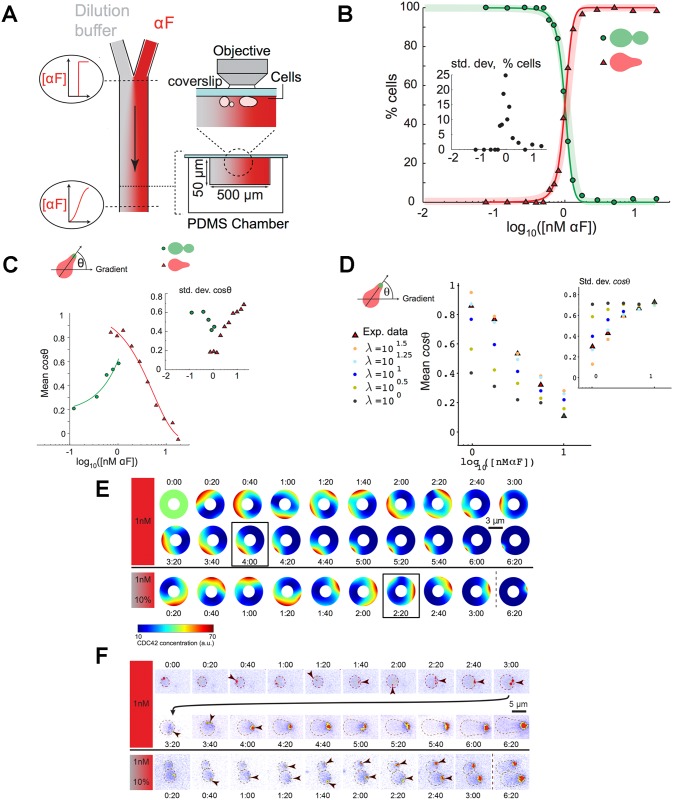
Response to pheromone gradients and model prediction.A) Producing pheromone gradients in a laminar flow chamber. Pheromone mixed with a fluorescent dextran and a dilution buffer enters through two ports and diffusion between the two fluid streams creates a temporally stable, gradient (see Experimental Procedures in S1 Text, and Fig C in S1 Text for more details). The left hand view is from the top of the apparatus and right hand views are two different magnifications of a cross-section, showing the cells attached to the coverslip that forms the roof of the chamber. B) The transition between budding and shmooing, quantified as in Fig 2B. The lightly shaded, thick curves show the data from spatially uniform pheromone concentrations (Fig 2B) for comparison. For every cell, the difference in concentration between the two edges of the cell was > 5% (expressed relative to the mean concentration that the cell experienced). The inset shows the standard deviation. C) The accuracy of gradient detection as a function of pheromone concentration. Accuracy is defined as the mean cosine of the angle between the gradient and the line that connects the Spa2 polar cap to the center of the cell. D) The accuracy of gradient detection as a function of pheromone concentration for solutions to our model. For different damping coefficients λ, the gradient detection and the standard deviation were computed. We observe that the value of λ which fits the data the best is 101.25 which means 1/λopt ≈ 3 mn. E) We show the timing of polarization in representative numerical simulations of cells exposed to a uniform field and gradient field of α-factor (images are shown every 20 minutes). F) Comparing the timing of polarization in individual cells exposed to a uniform field (top) and a gradient (bottom) of α-factor. Images were taken every 20 minutes and pseudocolored to indicate the intensity of Spa2-YFP fluorescence. Note the small unstable Spa2 spots (arrowheads) that appeared in the homogenously stimulated cell long before a stable polar cap, which took four hours to develop. In contrast, in the gradient, a small Spa2 spot first appeared in the direction of the gradient and then gradually grew stronger allowing the cell polarize much faster.